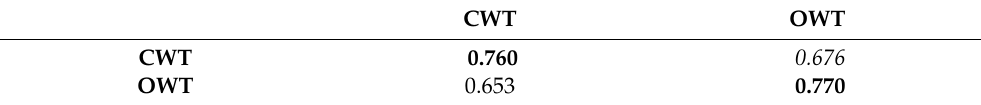
Table 4. Discriminant